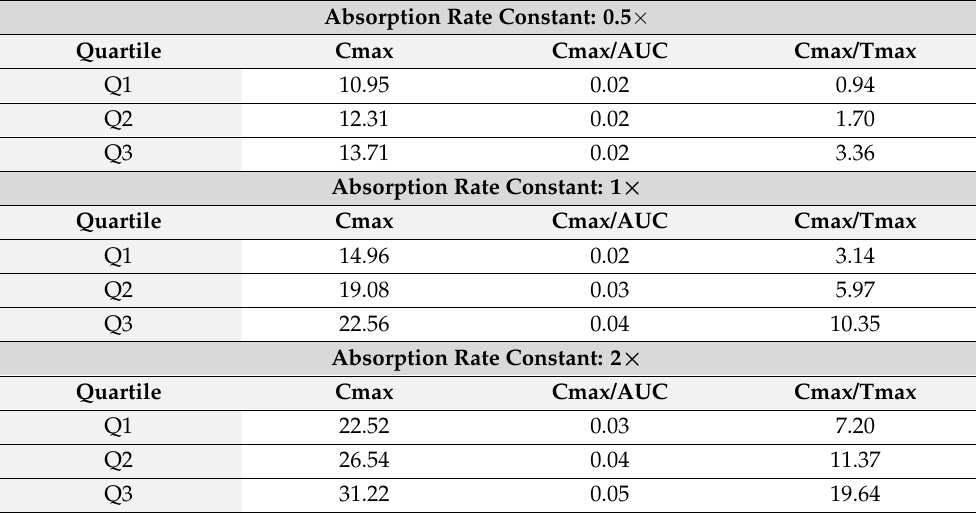
Table A2. Quartiles of the distribution of the Cmax, Cmax/AUC, and Cmax/Tmax estimates from the three simulated datasets. Simulations were performed assuming three different (mean) absorption rate constant (Ka) values: (a) half of the true Ka estimated from the population modeling, (b) equal to the true Ka, (c) twice the value of the actual